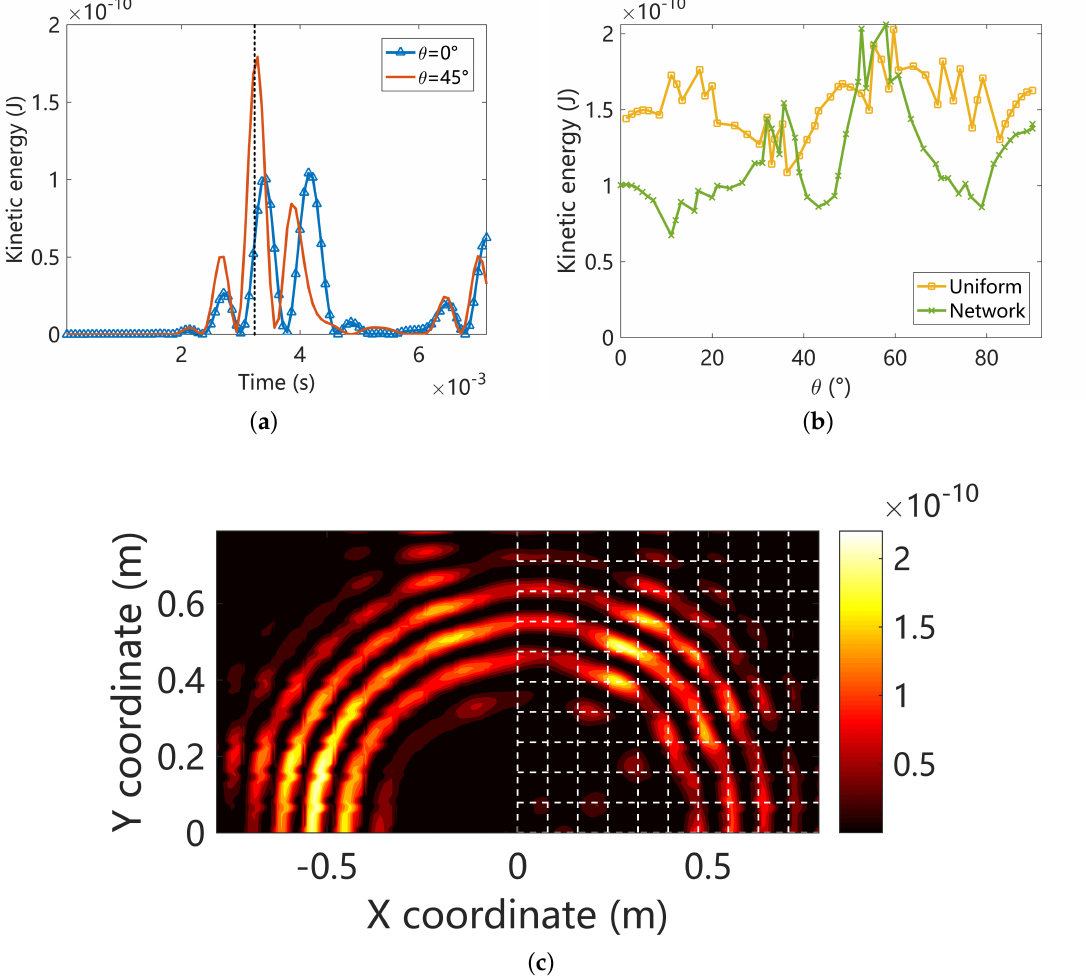
Figure 18. Summaries of the forced response results at 700Hz: ( a ) the time-history of the element kinetic energies at the monitor points with propagation angle θ = 0 and θ = π /4 in the piezoelectric composite; ( b ) The angular distribution of the instantaneous element kinetic energy at the monitor points; ( c ) The distribution of the instantaneous kinetic energy of the whole structure (only the upper half is shown due to symmetry). The results in Figure 18b,c are obtained at the same time point t = 3.4 × 10 − 3 s marked by the dotted line in Figure